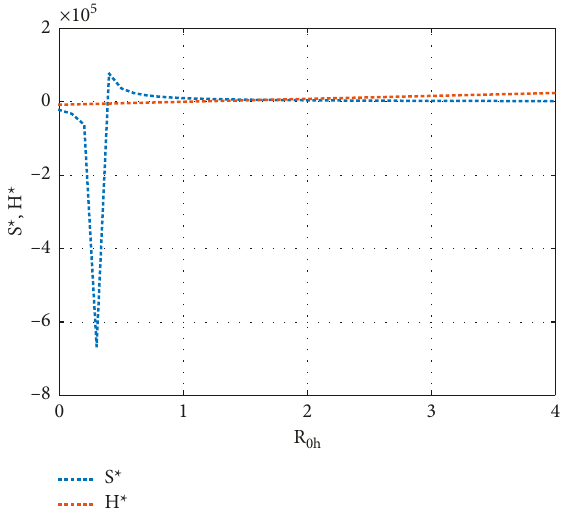
Figure 2: Forward bifurcation diagram of the HIV only